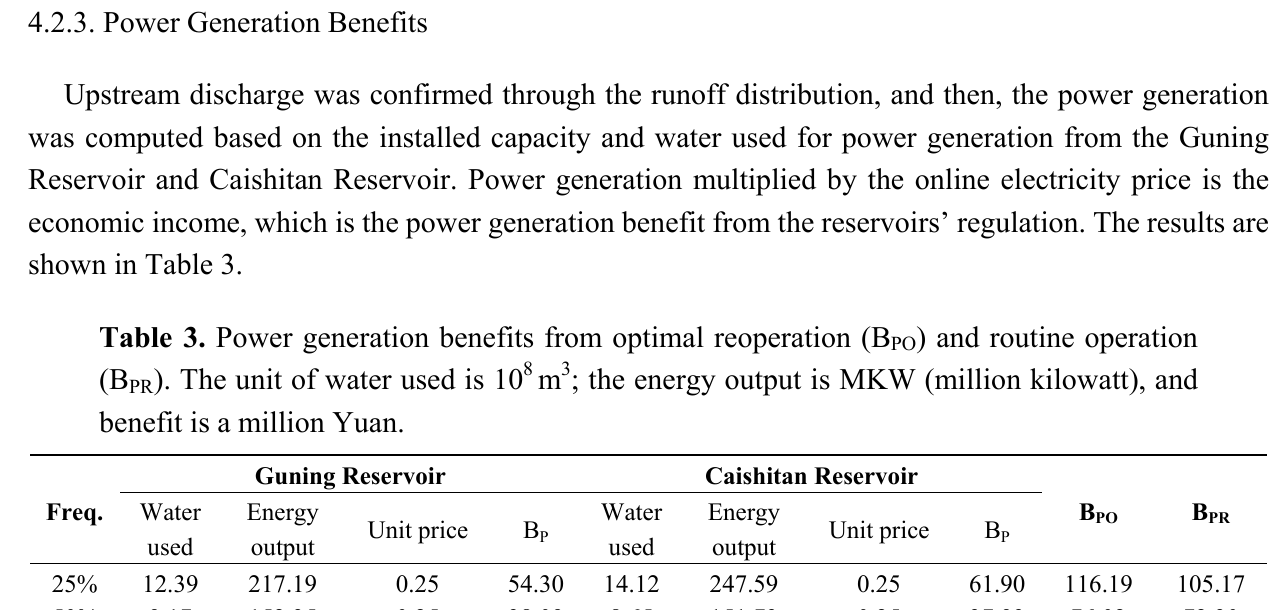
) and routine operation PO